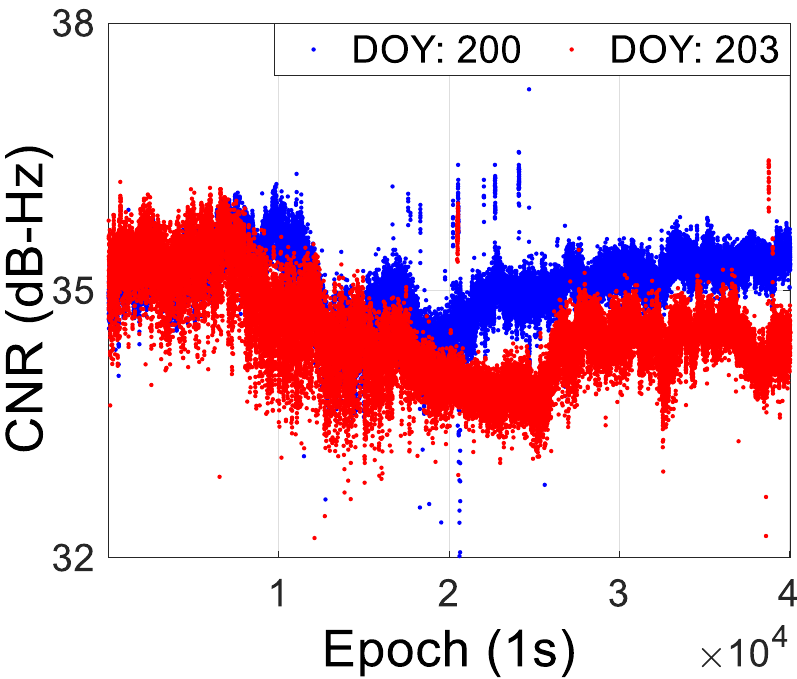
Figure 16. CNR of BDS GEO B01 satellite B1 frequency. The blue and red dots denote the CNR collected on DOY:200 (no flood) and DOY:203 (with flood), 2021, respectively.